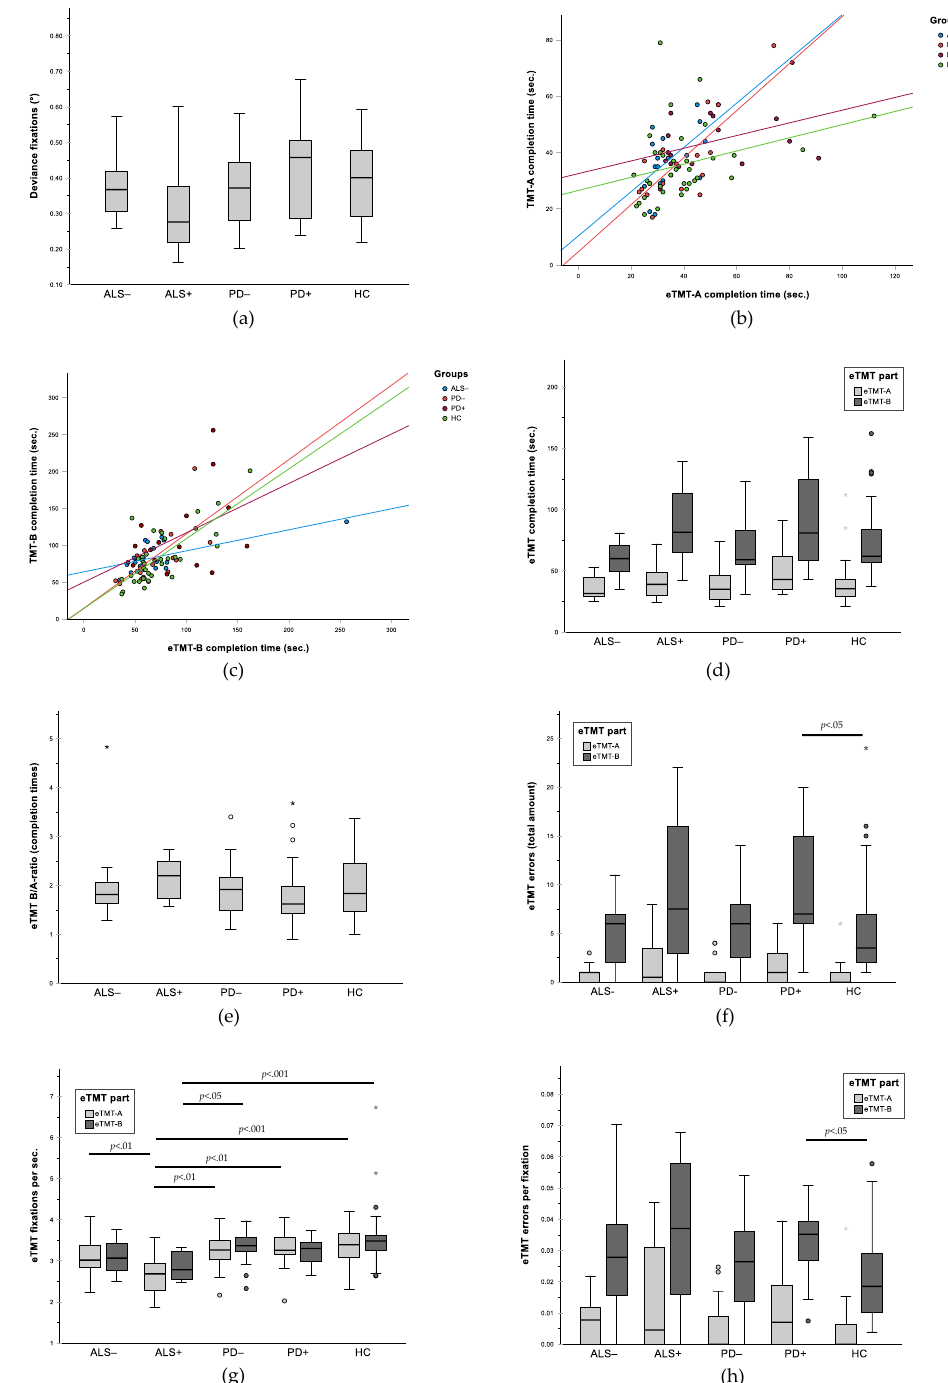
Figure 2. Group comparisons and correlations for gaze accuracy and performance in TMT and eTMT. ( a ) Deviance (in degrees) between target and fixation in calibration task as measure of gaze accuracy; ( b ) correlation between written TMT-A and eTMT-A; ( c ) correlation between written TMT- B and eTMT-B; ( d ) completion times for eTMT subtests in comparison between groups; ( e ) B/A ratio of completion times for eTMT subtests in comparison between groups; ( f ) total number of errors in eTMT subtests in comparison between groups; ( g ) fixations per second in eTMT subtests in comparison between groups; ( h ) errors per fixation in eTMT subtests in comparison between groups. In figures ( d – h ): ◦ outliers: values below the first quartile or above the third quartile with a distance of 1.5 to 3 times the interquartile range; * extreme outliers: values below the first quartile or above the third quartile with a distance of more than 3 times the interquartile